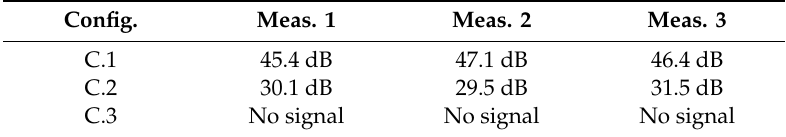
Table 2. Results of the special experiment on di ff erent configurations of the radiomodule and antenna. Config.